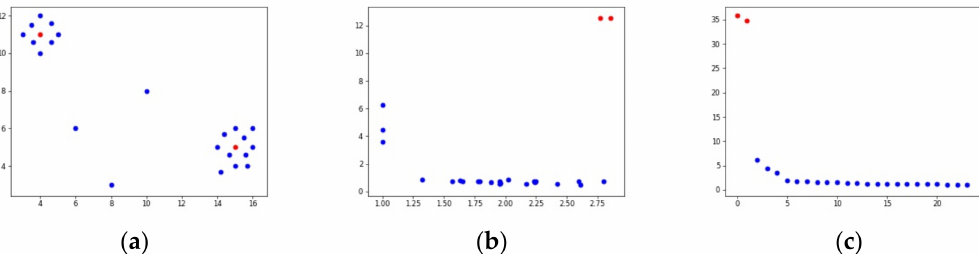
Figure 3. Example dataset distribution and calculation result ( a ) distribution of dataset; ( b ) distribution of local density and distance; and ( c ) product result of local density and